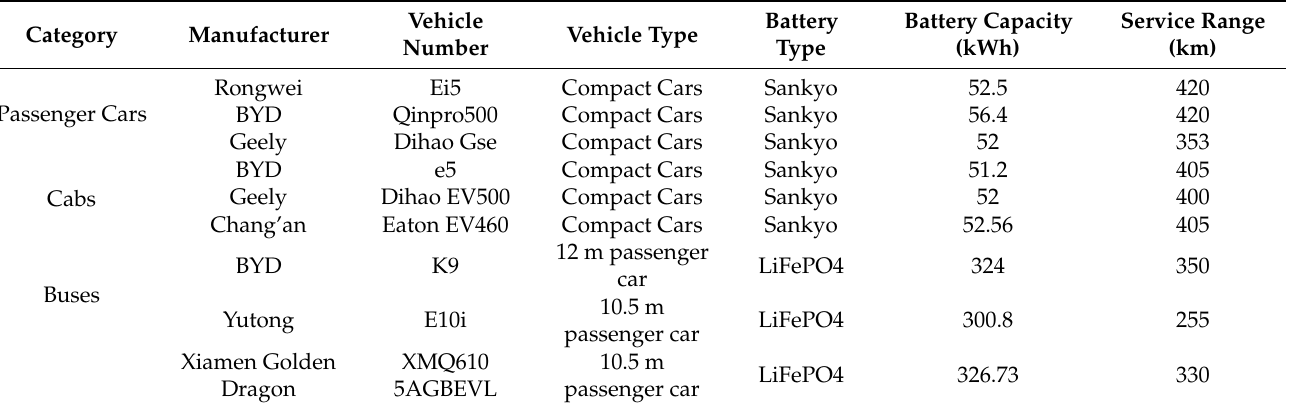
Table 1. Comparison of electric vehicle